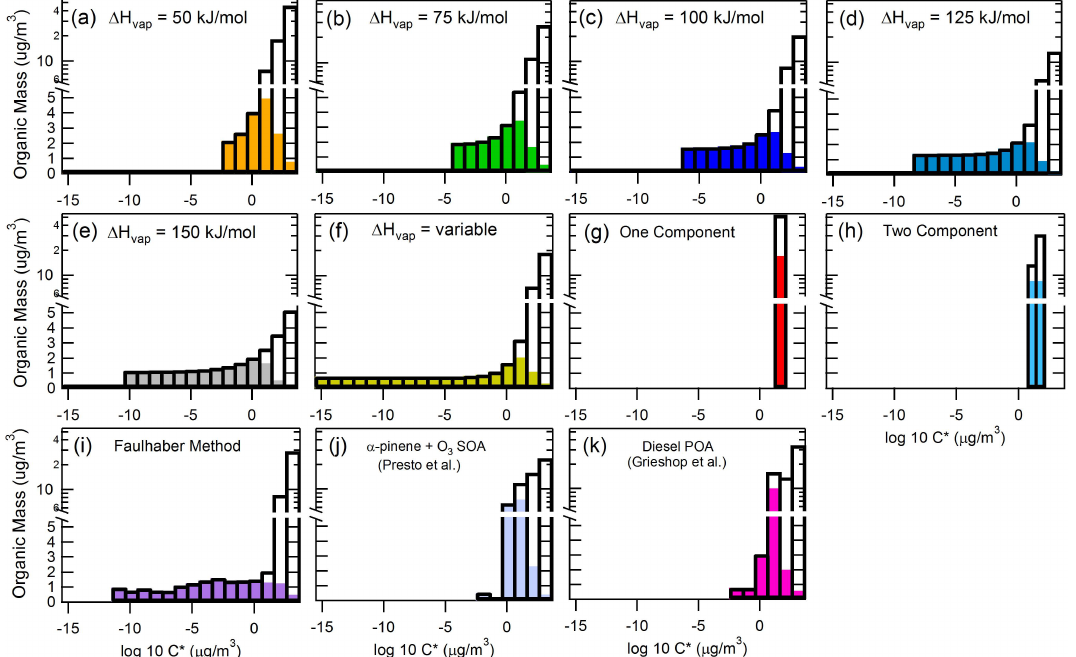
Fig. 2. The volatility distributions at 25 ◦ C corresponding to the MFR curves in Figure 1 are shown for assumed 1H vap values of (a) 50 kJ/mol, (b) 75kJ/mol, (c) 100kJ/mol, (d) 125kJ/mol, (e) 150kJ/mol and (f) the variable 1 H vap assumptions. Distributions are also shown for the (g) 1-component and (h) 2-component cases and (i) for that determined using the empirical relationship from Faulhaber et al. (2009). For comparison, volatility distributions for (j) SOA from the α -pinene + O 3 reaction (Presto et al., 2006) and (k) diesel emissions POA (Grieshop et al., 2009). Note that there is a break and change from linear to a log scale for the y-axis. In the distributions, the black boxes correspond to the total organic mass (gas + particle phase) and the colored boxes correspond to the particle phase